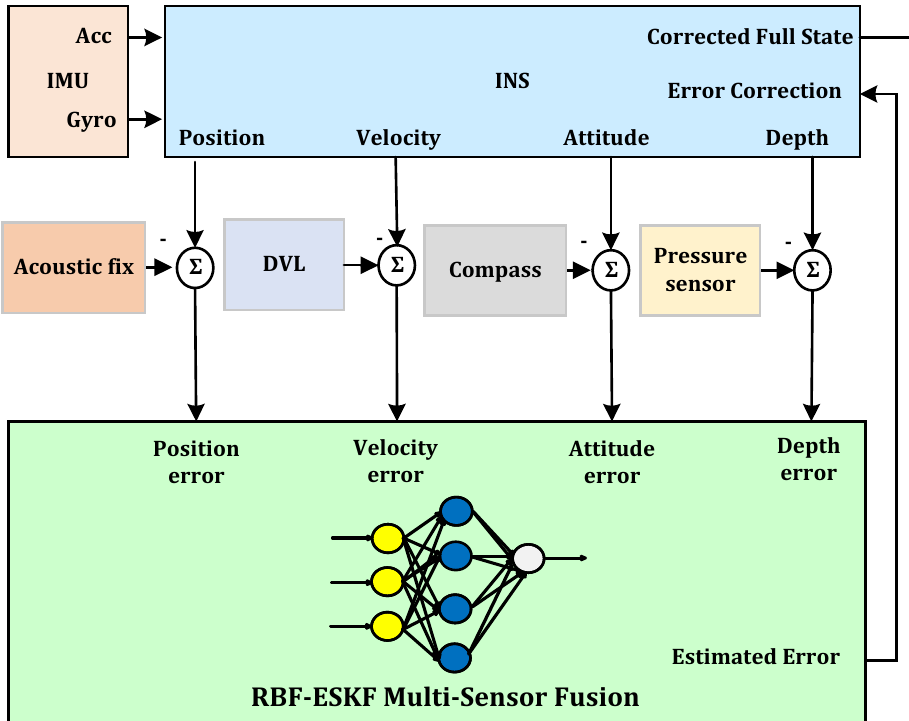
Figure 2. Top level diagram of the RBF-ESKF multi-sensor fusion navigation